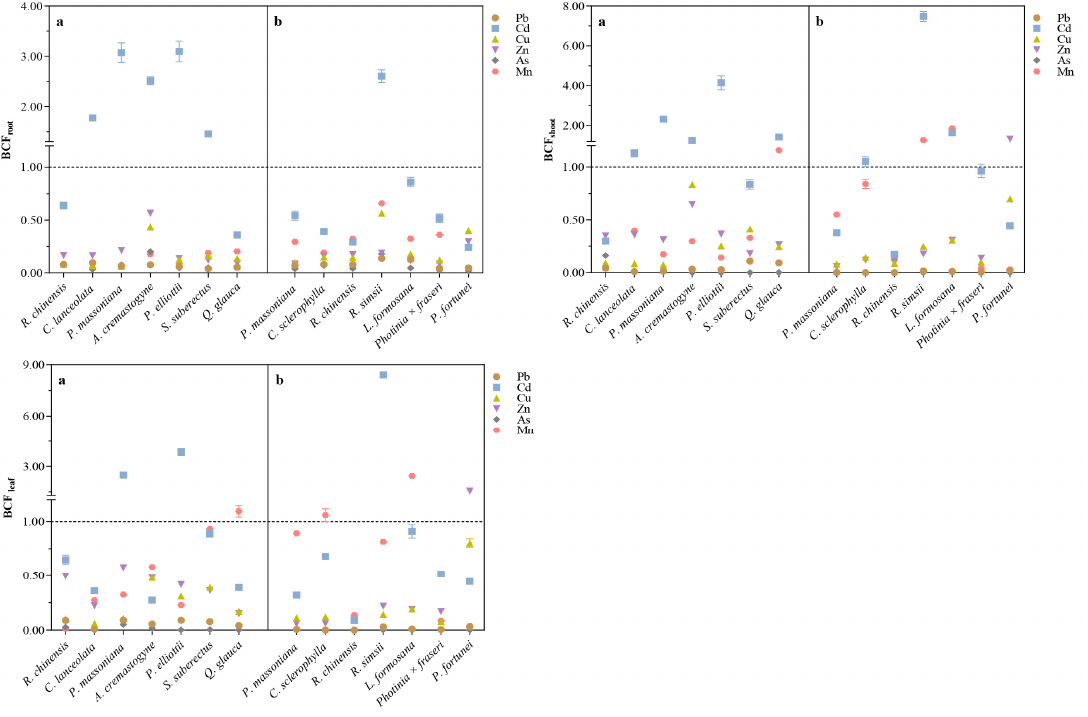
Figure 6. The BCFs of heavy metals in the roots, shoots, and leaves of each woody plant in the Jiulong iron tailing area ( a ) and Yangtiangang lead − zinc tailing area ( b ).